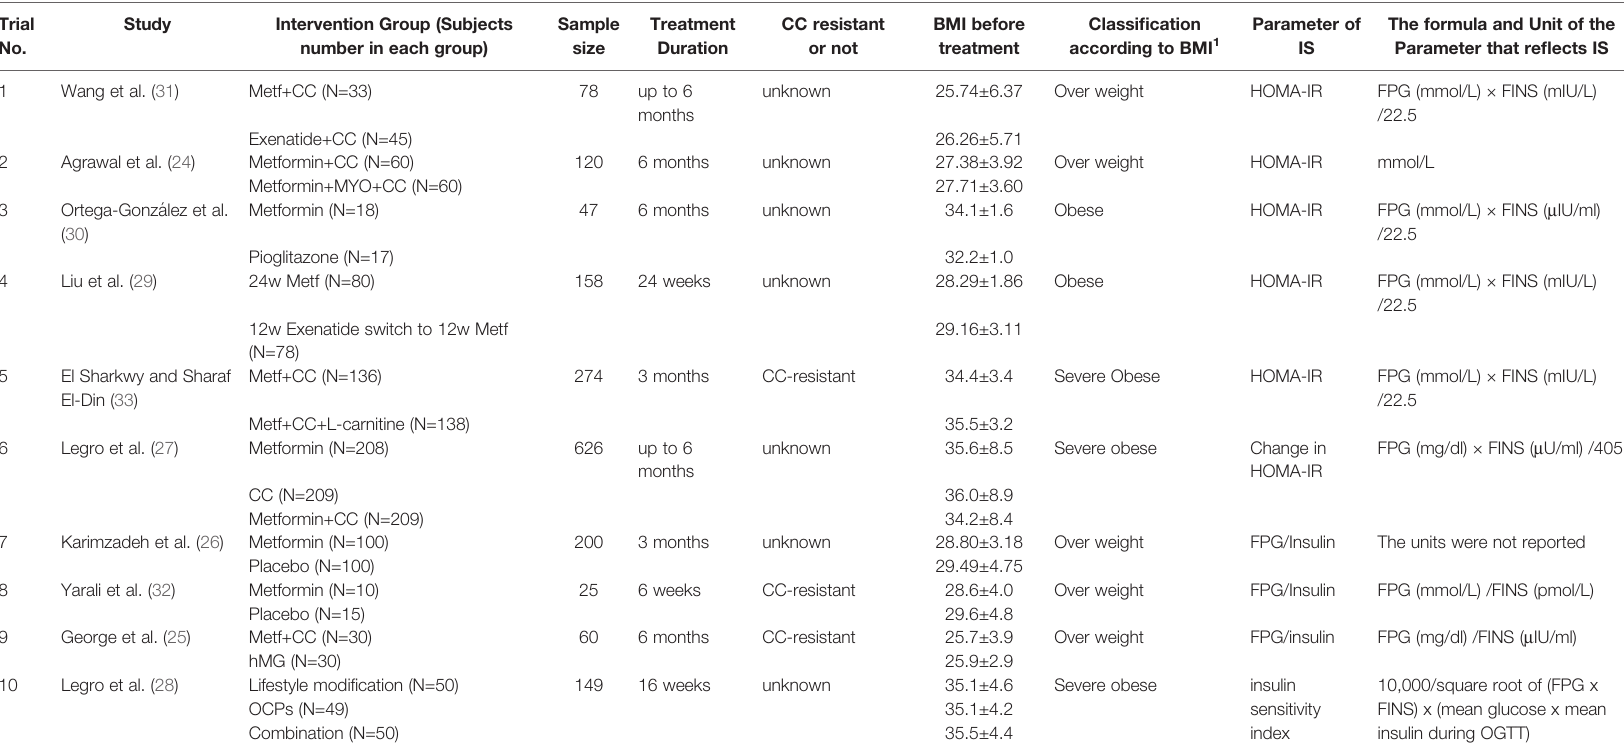
TABLE 1 | The sample size, treatment duration, the formula and units of the IS parameters, and the basic condition of subjects in the included RCTs. Trial No.